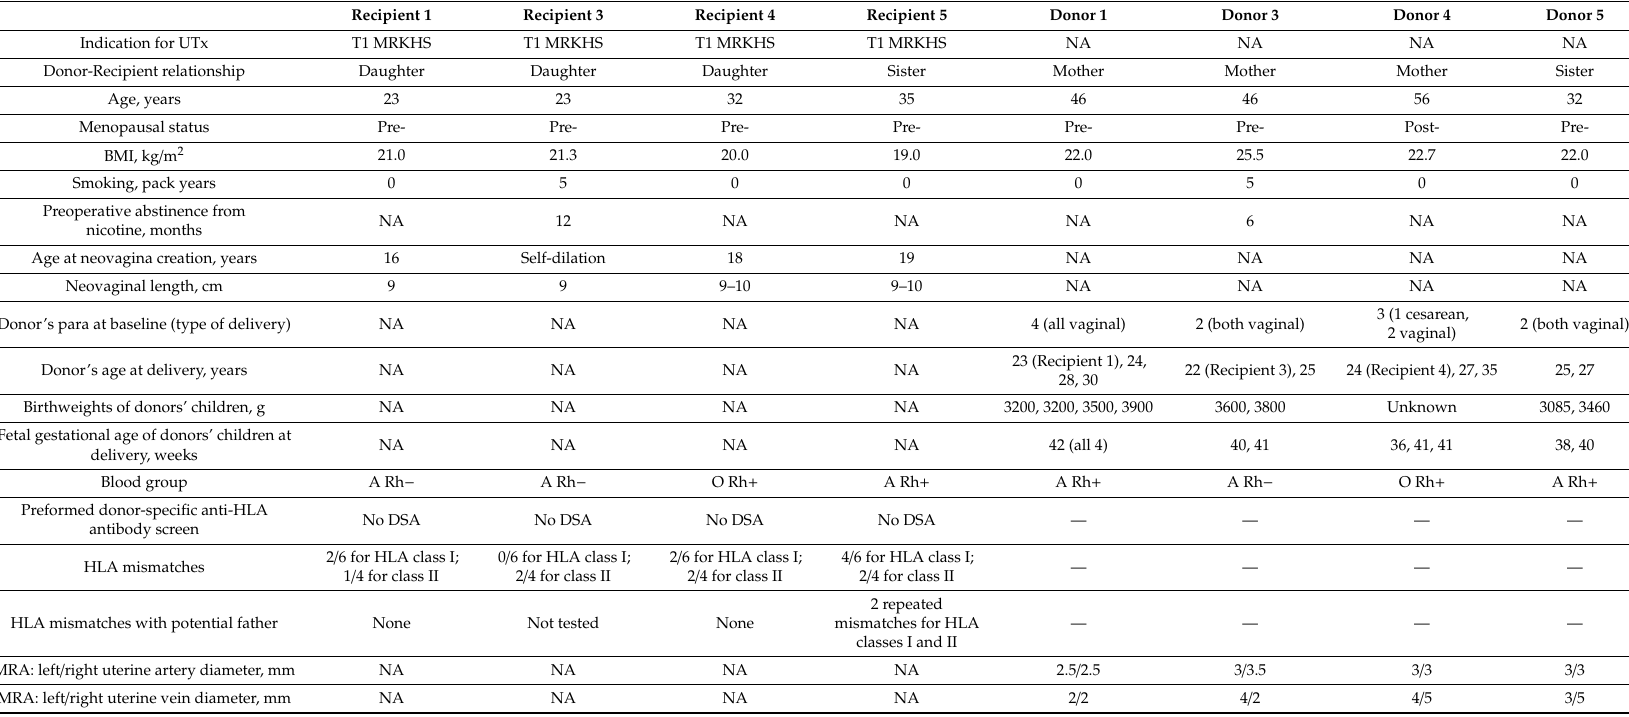
Table 1. Baseline clinical characteristics of recipients and donors before uterus